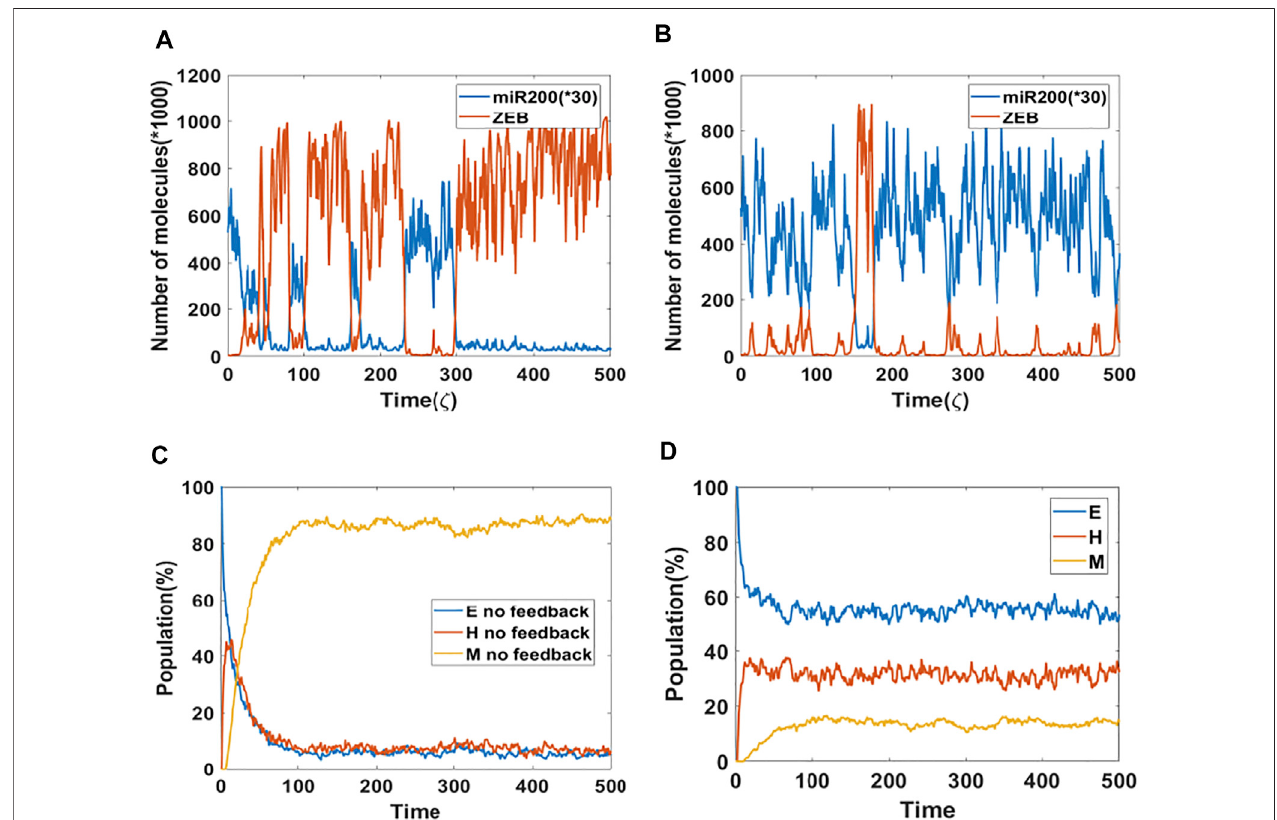
FIGURE 2 | Population dynamics of NRF2 mediated epigenetic feedback (A) A sample dynamic plot without epigenetic feedback. (B) A sample dynamic plot with feedback on the inhibition of SNAIL by NRF2. (C) Simulations showing the population change as a function of time. The percentage is calculated based on 1,000 independentsimulations.Thereisnoepigeneticregulation. (D) Sameas (C) butnowincludingepigeneticfeedbackontheinhibitorylinkfromNRF2toSNAIL.Epigenetic feedback by NRF2 stablizes hybrid state when competing with mesenchymal state.